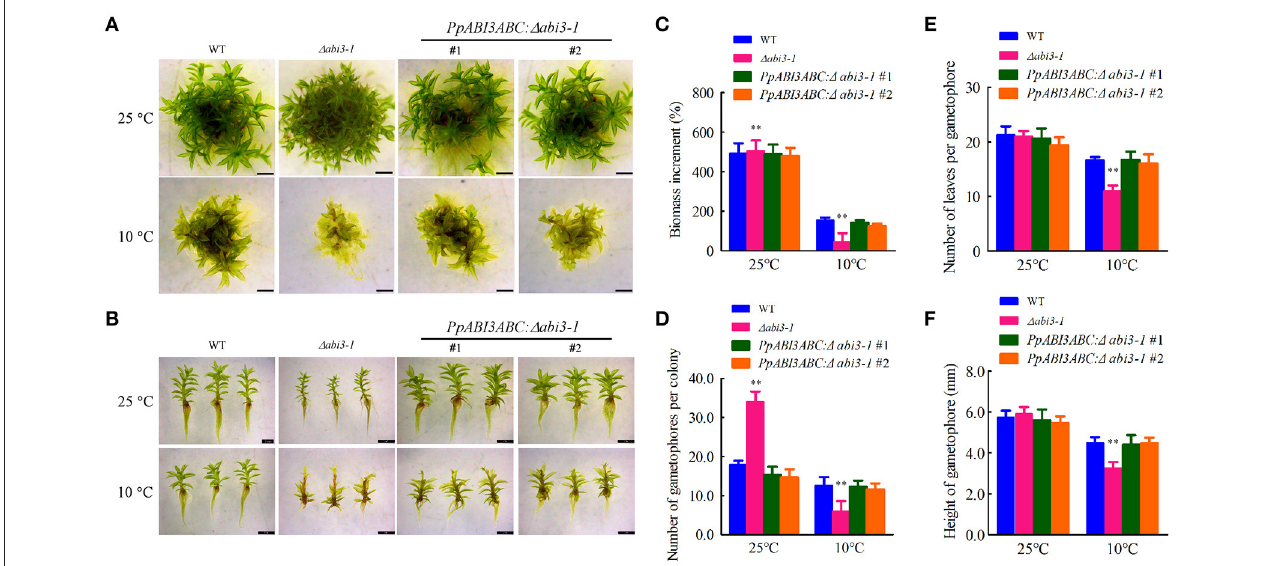
FIGURE 1 | Deletion of PpABI3 inhibits growth of P. patens under cold condition. (A) Analysis of gametophyte growth. Seven-day-old tissues of WT, ∆ abi3-1 and two complementary lines were inoculated on fresh BCD medium, and then grown under growth temperature (25 ◦ C) or lower temperature (10 ◦ C) for 4 weeks before photographs were taken. (B) Representative images of gametophores of each strains. Gametophores of wild type, ∆ abi3-1 and two complementary lines incubated under 25 ◦ C or 10 ◦ C were collected to show their different phenotypes. Bar = 2 mm for all panels. (C) Analysis of biomass increment in (A) . Fresh weight of each strain was determined for biomass increment analysis in relation to the starting inoculated biomass. Error bars represent SD ( n = 3) and Two-way ANOVA was used to determine the statistical significance (** P < 0.01). (D) Number of gametophores that emerged on the colonies of each strain. The colonies were incubated under 25 ◦ C or 10 ◦ C for 4 weeks and gametophores that emerged were counted. Error bars indicate mean ± SD ( n = 6) and Two-way ANOVA was used to determine the statistical significance (** P < 0.01). (E) Number of leaves that generated per gametophore of each strain. The colonies were incubated under 25 ◦ C or 10 ◦ C for 4 weeks and representative gametophores were collected for estimation of the leaves amount. Error bars indicate mean ± SD ( n = 10) and Two-way ANOVA was used to determine the statistical significance (** P < 0.01). (F) Mean height of gametophores analysis for the wild type, ∆ abi3-1 and PpABI3ABC : ∆ abi3-1 lines. Error bars indicate mean ± SD ( n > 60) and Two-way ANOVA was used to determine the statistical significance (** P < 0.01).